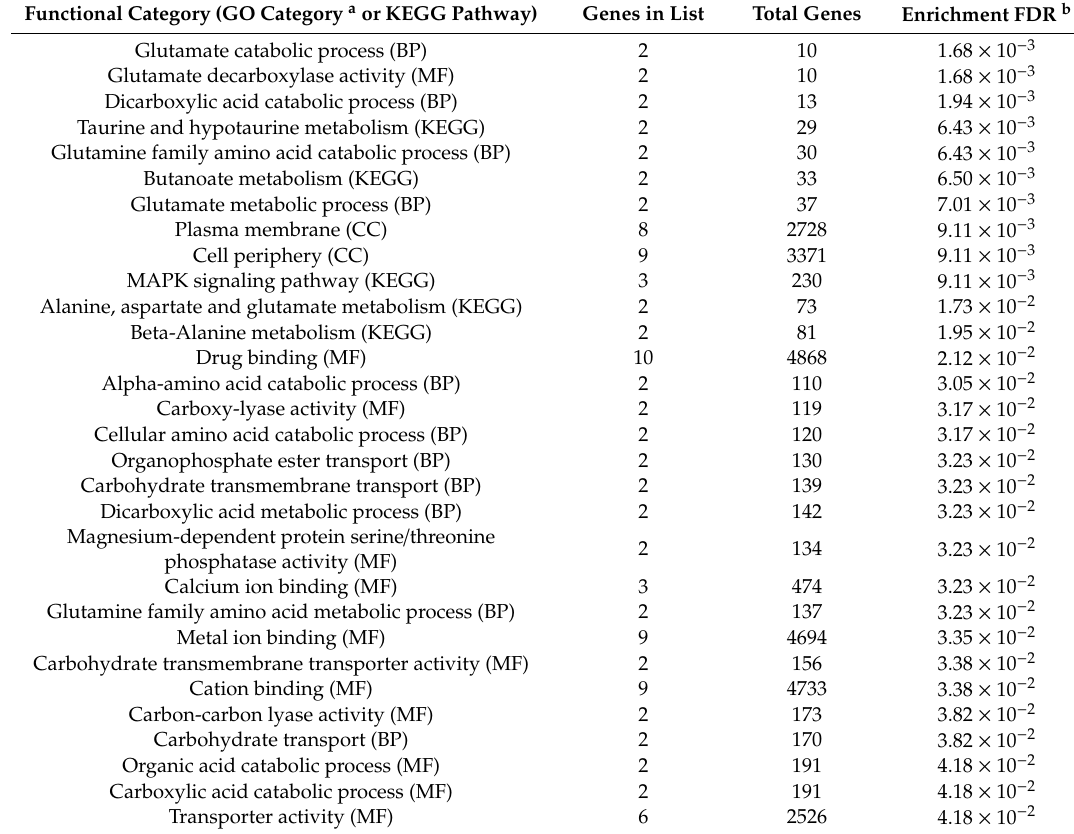
Table 3. Gene ontology (GO) enrichment analysis and Kyoto Encyclopedia of Genes and Genomes (KEGG) pathway analysis of di ff erentially expressed genes in chitin nanofiber-treated soybean plants. Functional Category (GO Category a or KEGG